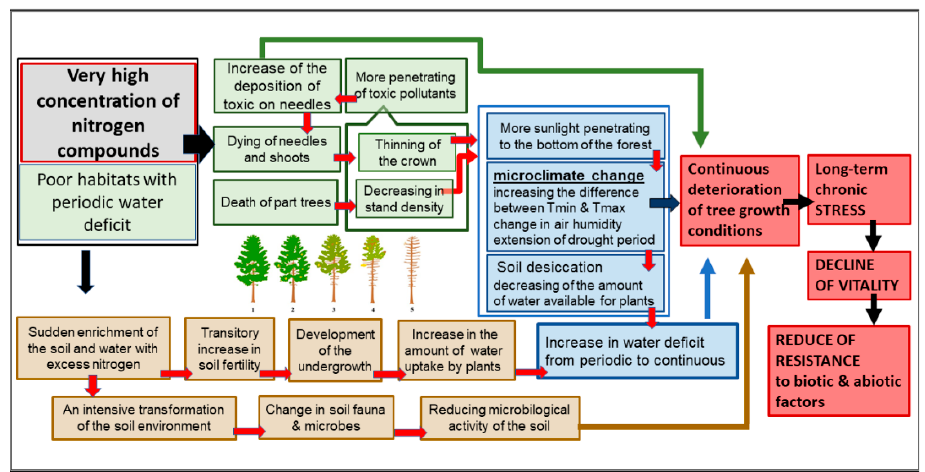
Figure 11. Concept of the direct and indirect impact of air pollution on the growth of the Scots pine stands under study. Explanation of the colours used in the figure: green—changes taking place in pine trees; blue—changes in the microclimate and water available; brown—changes in the soil environment; red- changes in vitality of Scots pine.